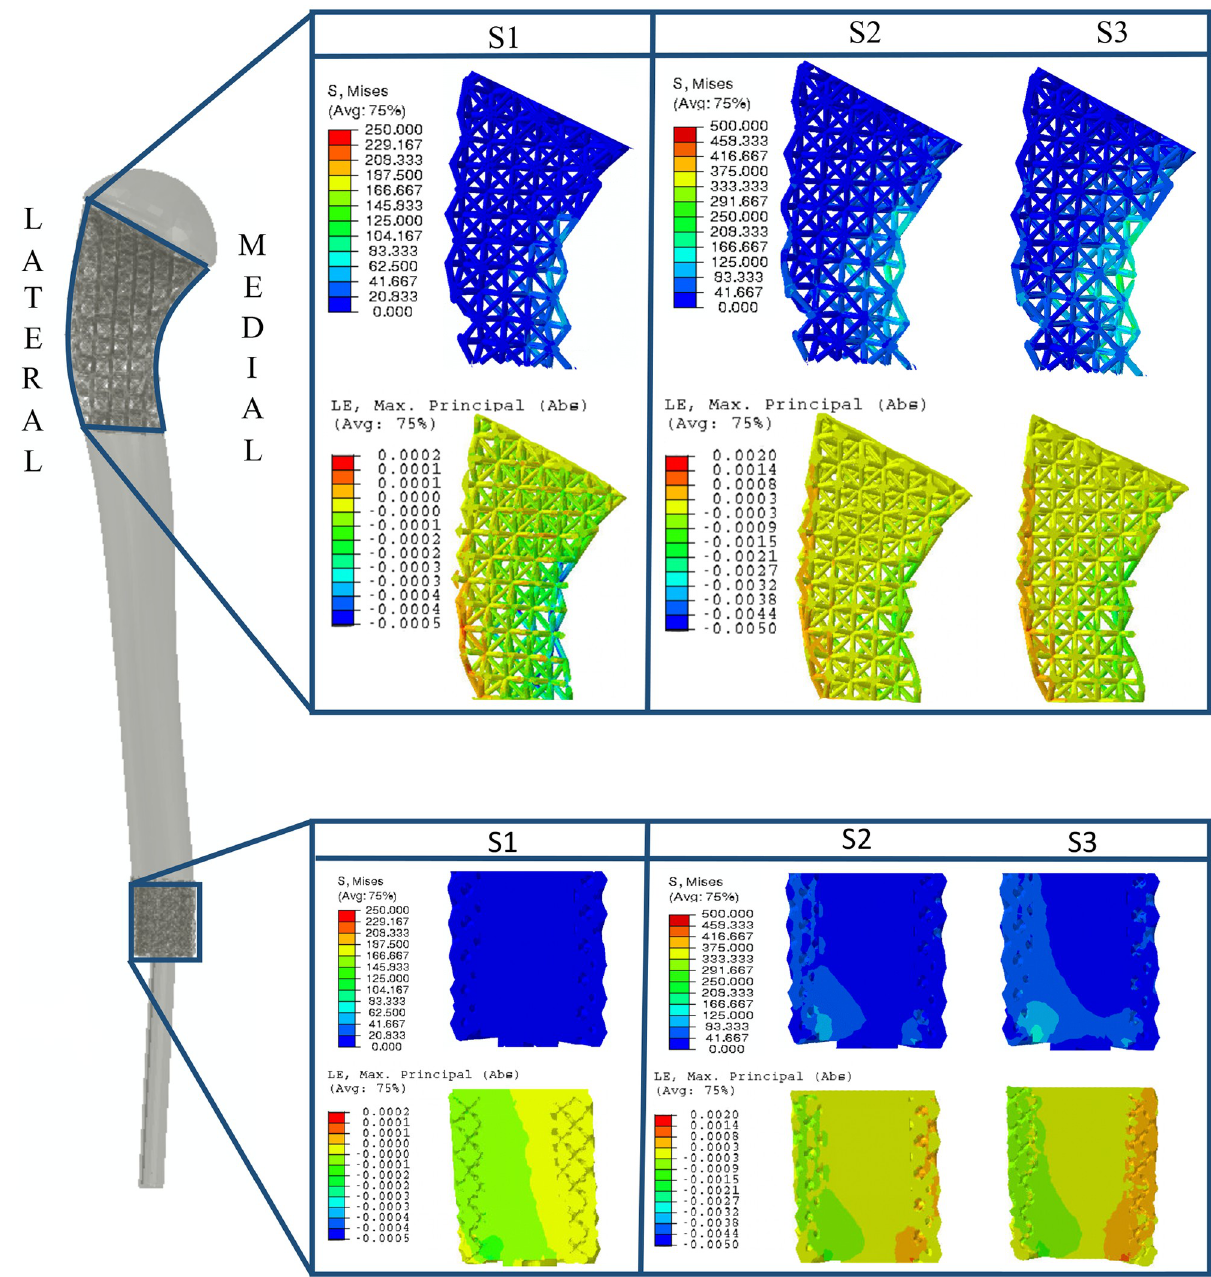
Fig 6. FEA results: Von Mises stress (MPa) and maximum principal strain (absolute values) distributions across porous regions of the patient- specific AM prosthesis. https://doi.org/10.1371/journal.pone.0253786.g006 3.3.2. Surface roughness. Surface morphology analysis (i.e., height and amplitude rough- ness parameters) was performed on the patient-specific prosthesis using optical non-contact